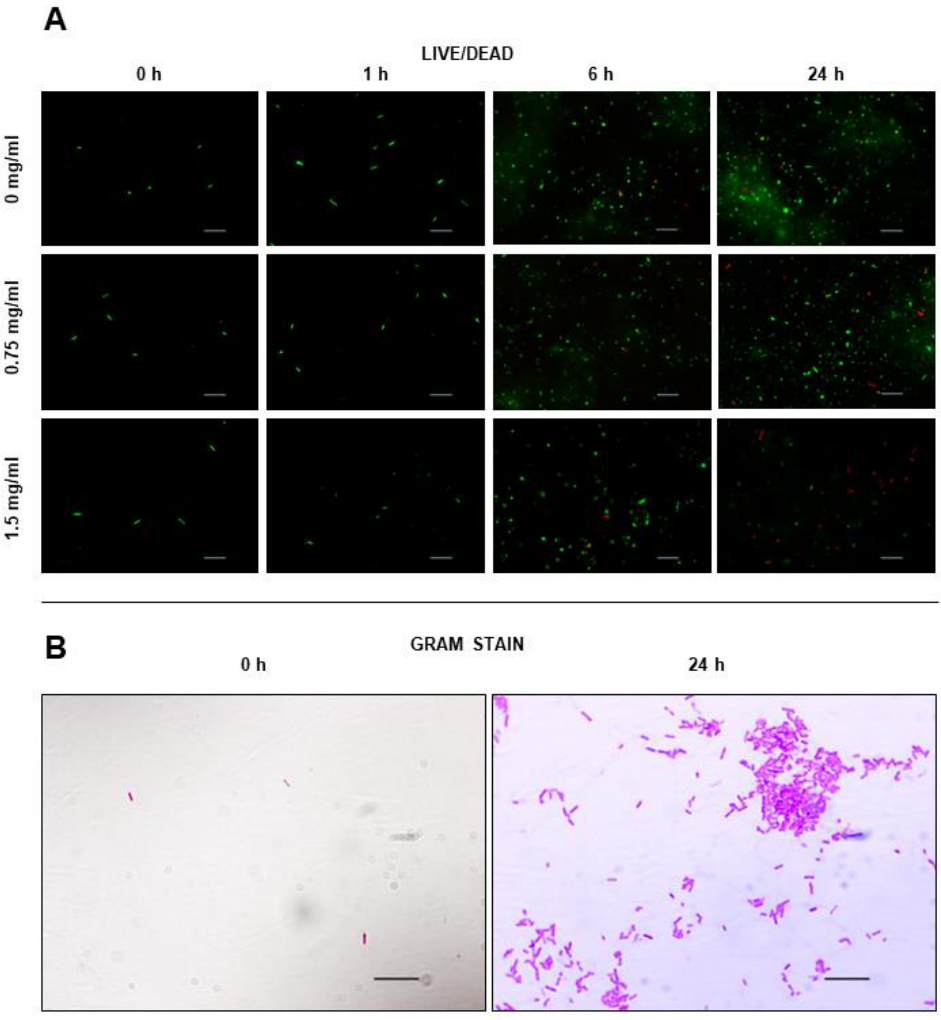
Figure 5. ( A ) Live/Dead staining of E. coli ATCC 25922 cells with an FF concentration of 0 mg/mL, 0.75 mg/mL and 1.5 mg/mL at 4 timepoints (0 h, 1 h, 6 h and 24 h); ( B ) Gram staining of E. coli ATCC 25922 at 2 timepoints (0 h and 24 h). Scale bar in ( A ) and ( B ): 10 µm.